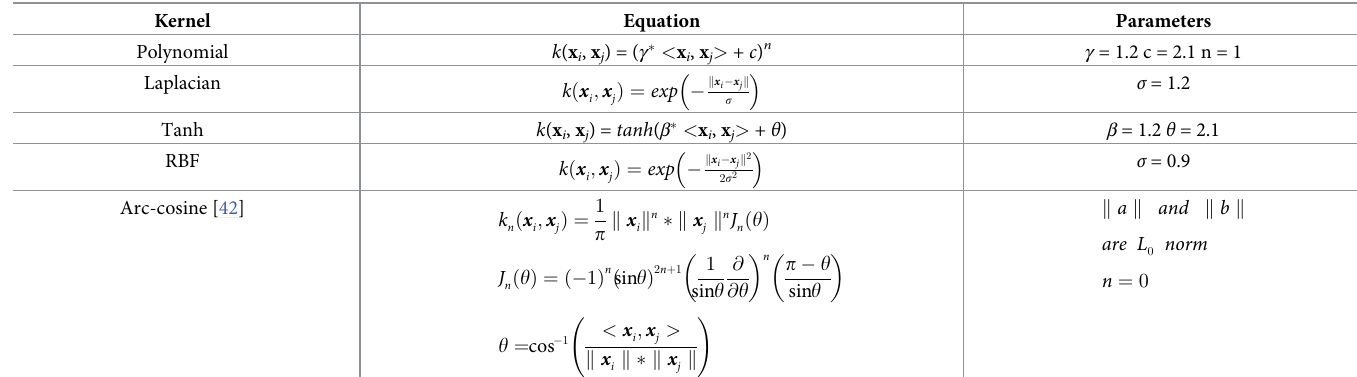
Table 1. Kernel parameters setting.